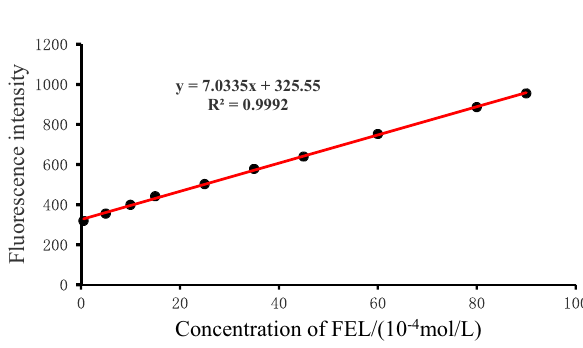
Figure 7: Standard curve of FEL concentration and fl uorescence intensity.